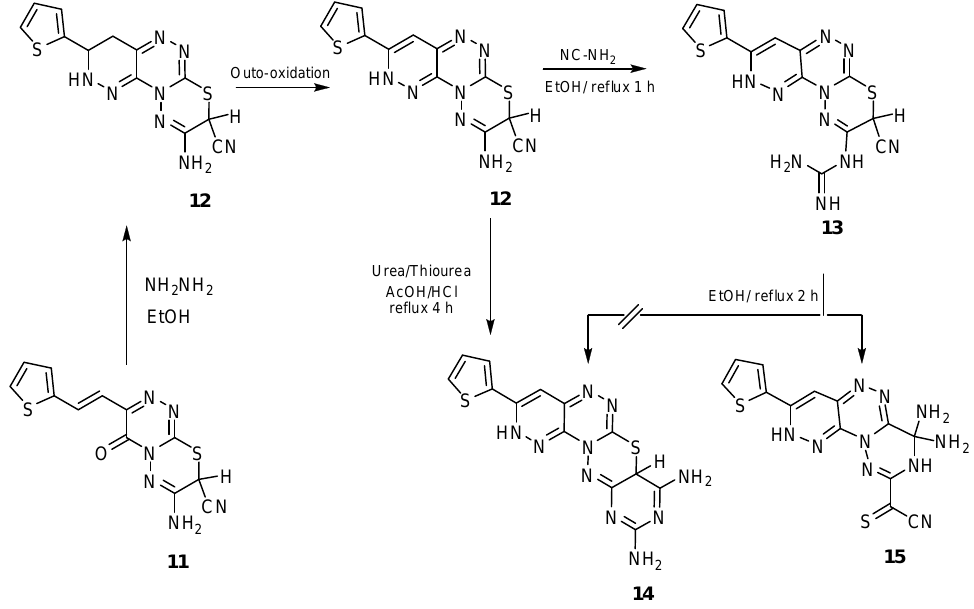
Scheme 3. Synthesis and some reactions of 3-amino-3-(2-thienyl)-2 H ,8 H -pyridazino[3 (cid:48) ,4 (cid:48) :5,6][1,2,4] 3. Synthesis and some reactions of 3-amino-3-(2-thienyl)-2 H ,8 H -